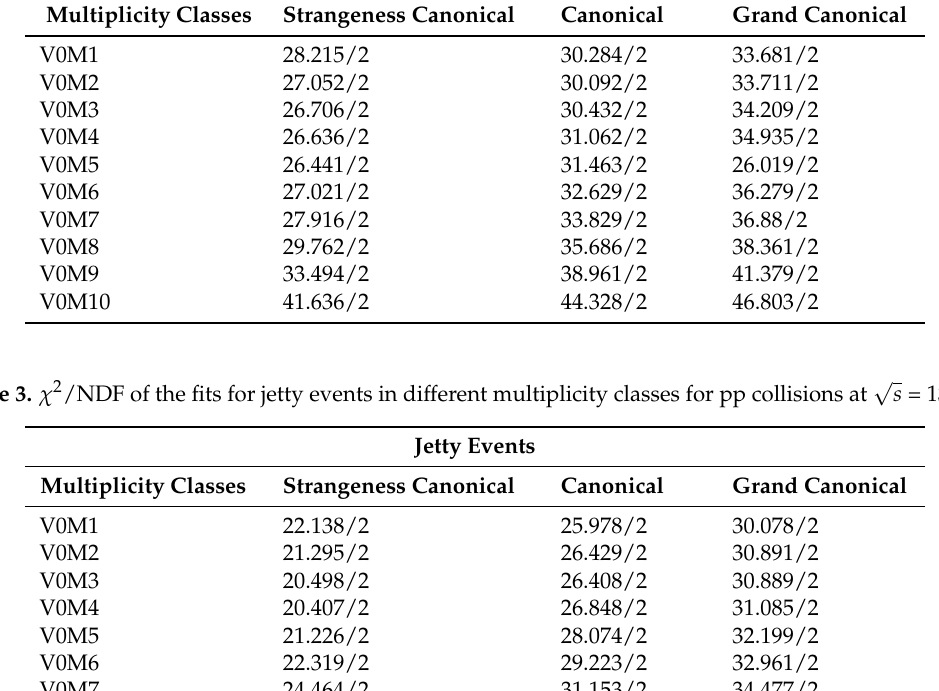
Table 2. χ 2 /NDF of the fits for isotropic events in different multiplicity classes for pp collisions at √ s = 13 TeV.